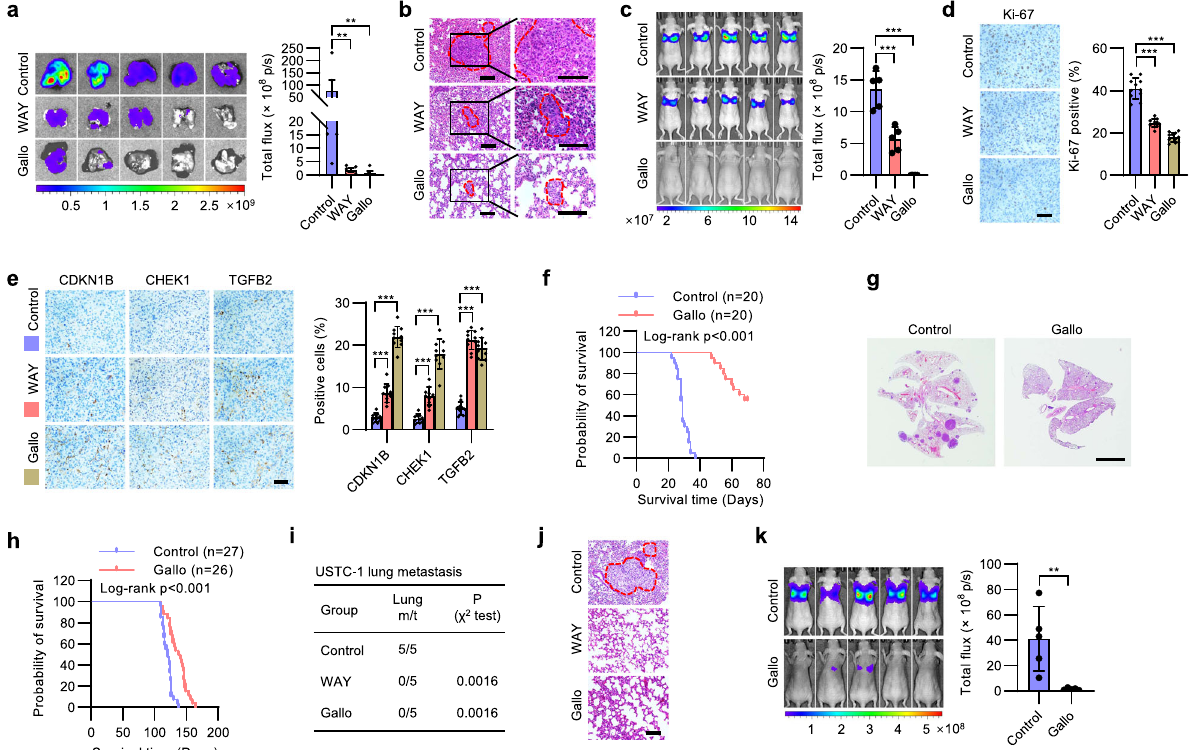
Fig. 4 Targeting DKK1 ameliorates metastatic progression. a , b BLI ( a ) and H&E staining ( b ) of the lungs from mice orthotopically implanted with 2 × 10 6 MDA-MB-231-luc cells. The mice were treated with vehicle, WAY262611 or Gallocyanine. Metastatic sites are circled in red. Scale bar: 100 μ m. c BLI of the metastatic burden of mice intravenously injected with 1 × 10 6 MDA-MB-231-luc cells. The mice were treated with vehicle, WAY262611 or Gallocyanine. d , e IHC staining of Ki-67 ( d ) or CDKN1B, CHEK1 and TGFB2 ( e ) in lung sections from mice intravenously injected with MDA-MB-231-luc cells. The mice were treated with vehicle, WAY262611 or Gallocyanine. Scale bar: 50 μ m. f Survival curve of mice intravenously injected with 1 × 10 6